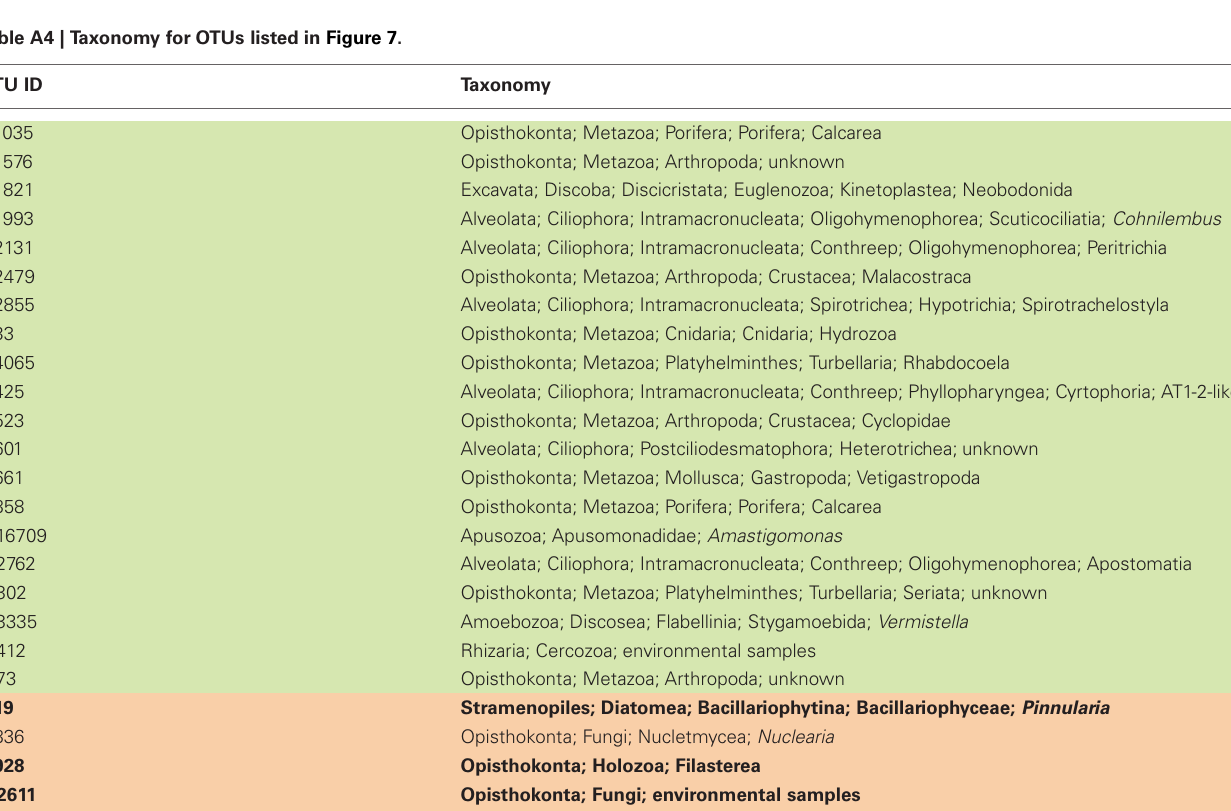
Significant OTUs are indicated with an asterisk.